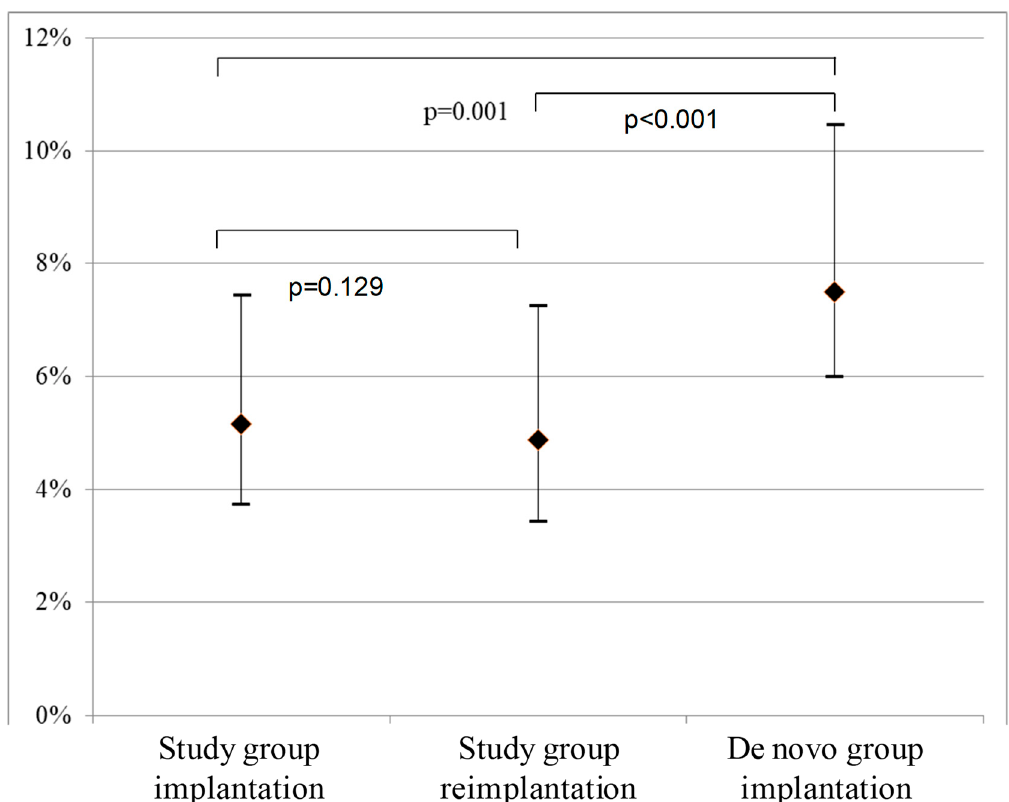
Figure 1. Calculated 5-year SCD risk (median and IQR) in the study group and de novo